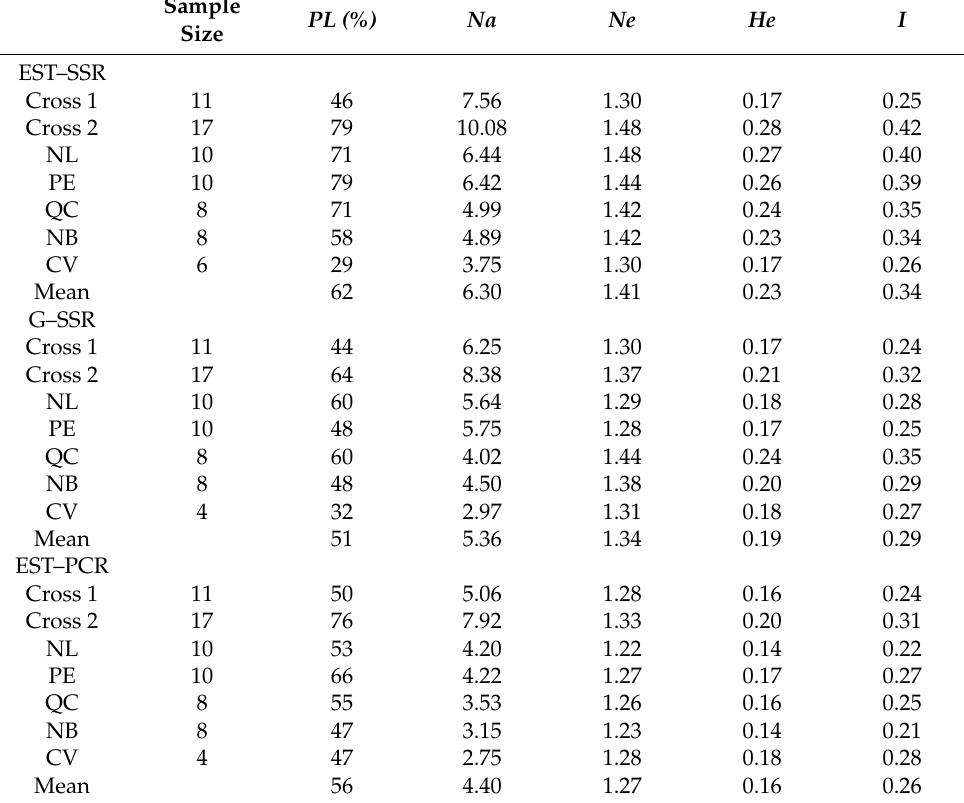
Table 5. Population genetic diversity parameters of blueberry hybrid groups (Cross 1: HB1–11; Cross 2: HB12–28), wild clones collected from Canadian provinces Newfoundland and Labrador